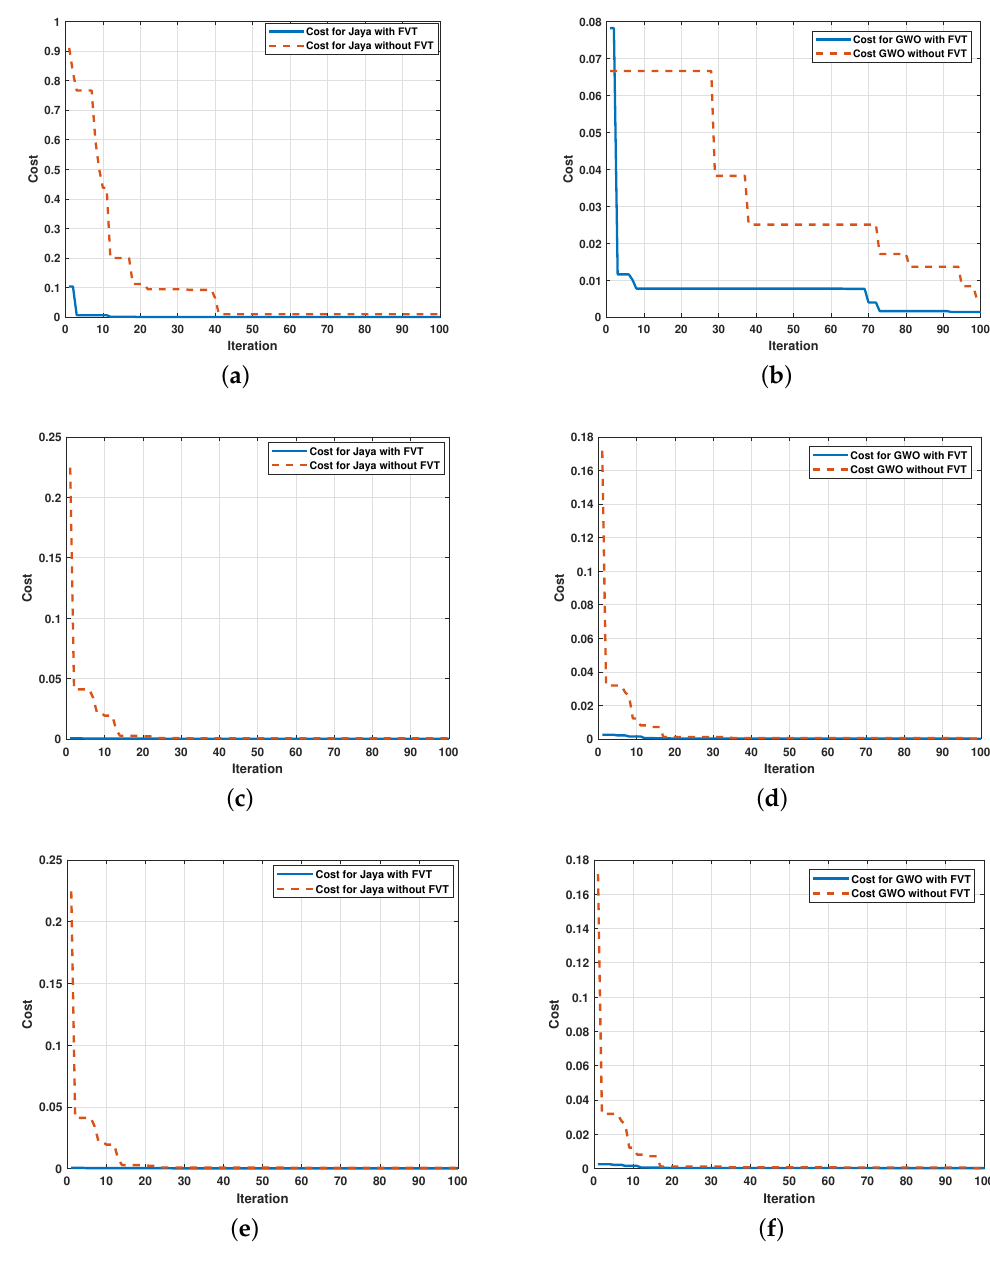
Figure 10. Convergence speed of metaheuristic algorithms: ( a ) Comparison of performance of the Jaya using the FTV in the RLC system; ( b ) Comparison of performance of the GWO using the FTV in the RLC system. ( c ) Comparison of performance of the Jaya using the FTV in the mechanical system; ( d ) Comparison of performance of the GWO using the FTV in the mechanical system; ( e ) Comparison of performance of the Jaya using the FTV in the electromechanical system; ( f ) Comparison of performance of the GWO using the FTV in the electromechanical